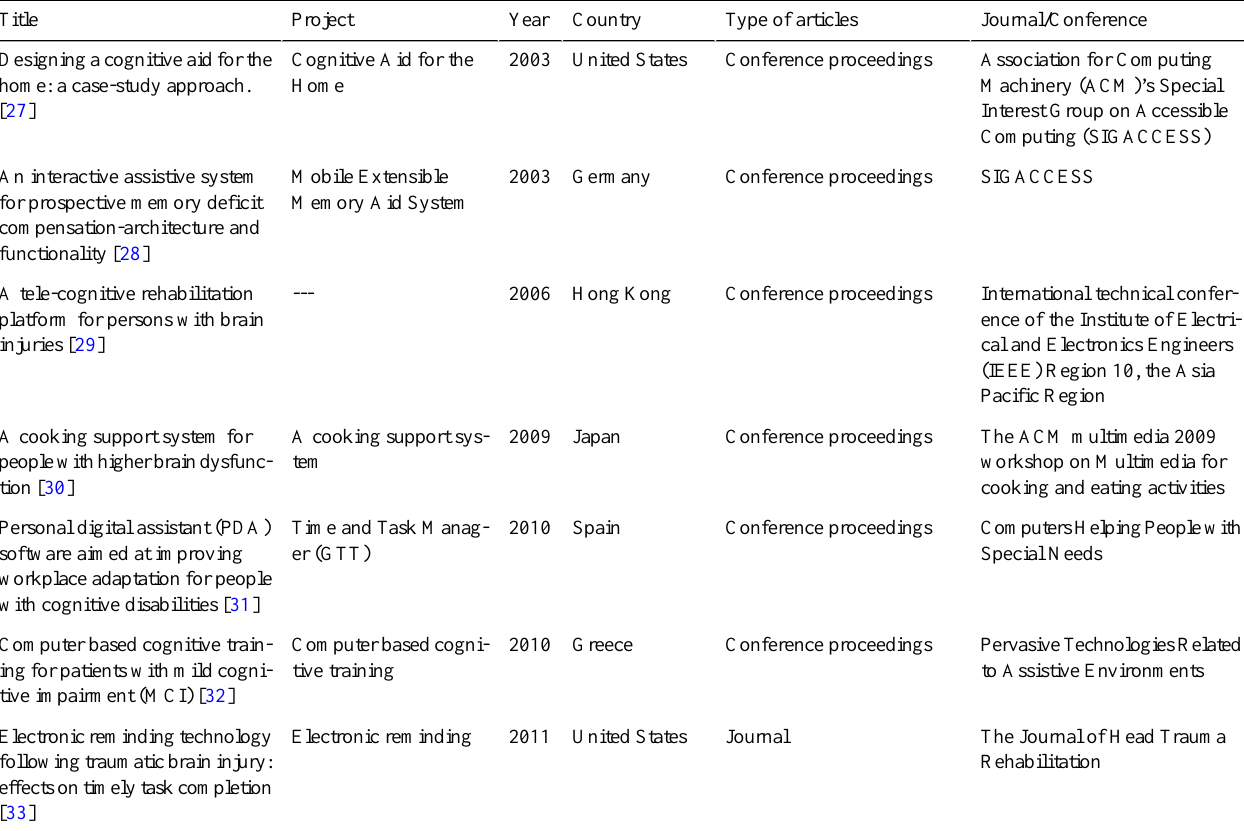
Table 2. General details about the studies that met the inclusion